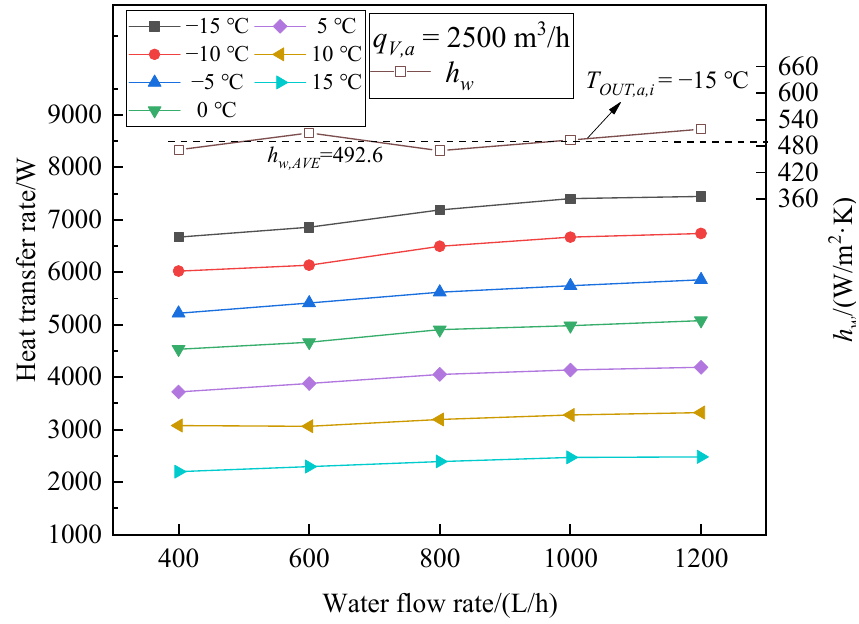
Figure 9. Variation of the heat transfer rate under different water flow rates. As shown in Figure 8, the outdoor environment temperature at − 15 ◦ C is selected for analysis. When q V , a increases, the same trends of the heat transfer rate are observed at different outdoor temperatures. When q V , a is less than 1000 m 3 /h, the heat transfer rate is at a relatively low level, and the convective heat transfer coefficient is below 46 W/(m 2 · K). As q V , a increases to 1500 m 3 /h, the heat transfer rate increases by 34.5% more than that of 1000 m 3 /h. A larger slope (Slope 1) is noted at this stage; the disturbance of the air flow is enhanced by the serrated fins, and the convective heat transfer coefficient is 54.8 W/(m 2 ·